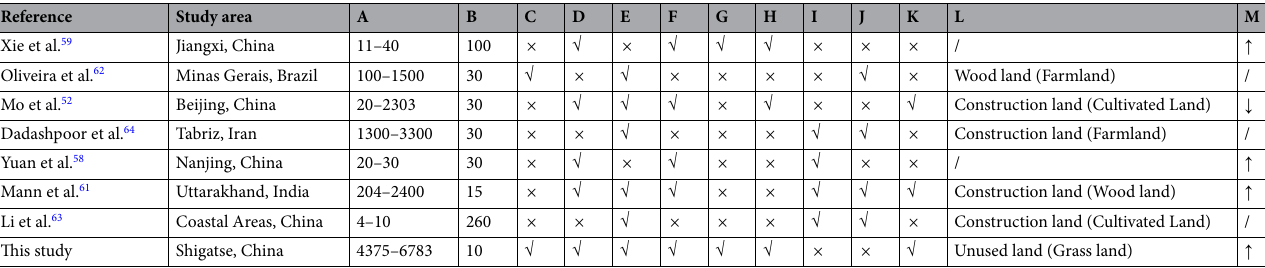
Table 8. Comparison of research methods and main results with existing studies. A: The main altitude of the study area, B: Remote sensing image resolution adopted (meter), C: Buffer analysis, D: Ecological risk model, E: Analysis of landscape pattern change, F: Analysis of ecological risk change, G: Global spatial autocorrelation analysis, H: Local spatial autocorrelation analysis, I: Regression analysis, J: Considerations of social or economic factors, K: Considerations of the impact of road construction, L: Landscape types with the largest area increase (decrease), M: Change of overall ecological risk (“ ↑ ” indicates increased risk, “ ↓ ” indicates decreased